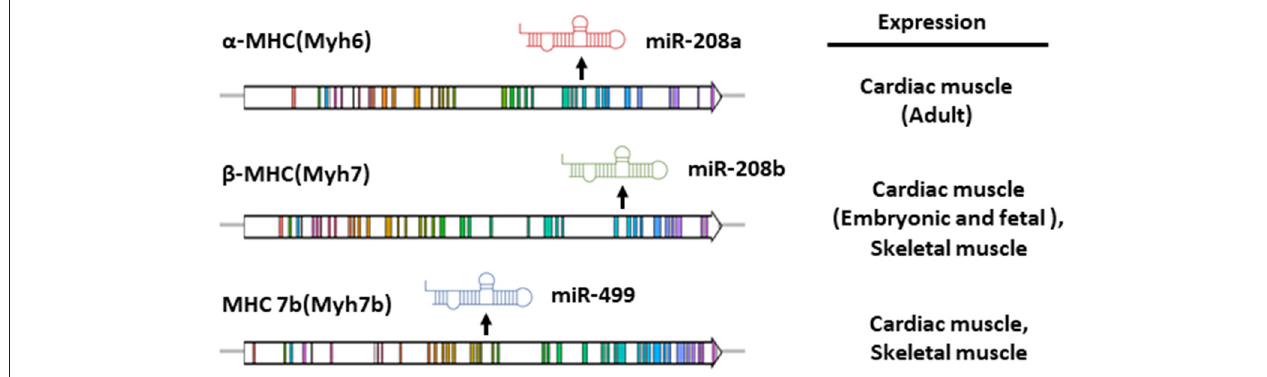
FIGURE 1 | Gene structure and expression pattern of miR-208a, miR-208b and miR-499 and their host genes in mouse. The intronic miR-208a, miR-208b and miR-499 are co-transcribed with their host genes, Myh6, Myh7 and Myh7b